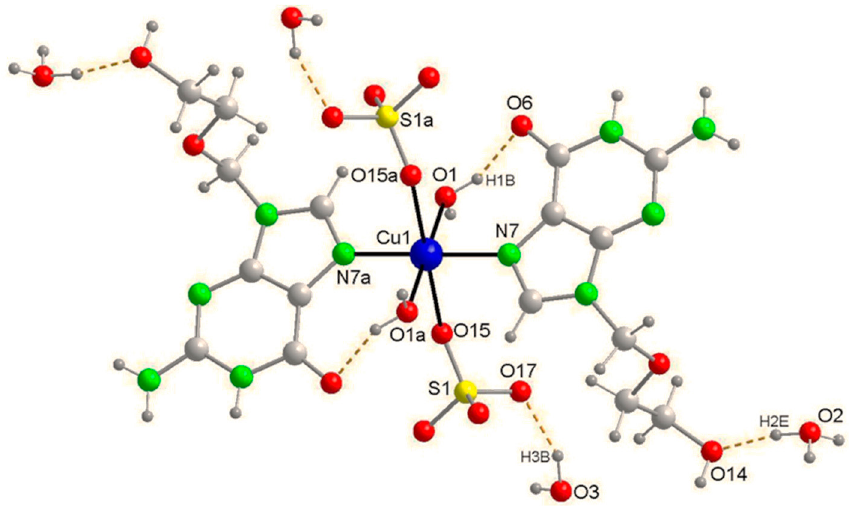
Figure A2. Structure of compound 1 , corresponding to two symmetry-related asymmetric units (symmetry transformation, a : − x, − y + 1, − z ).